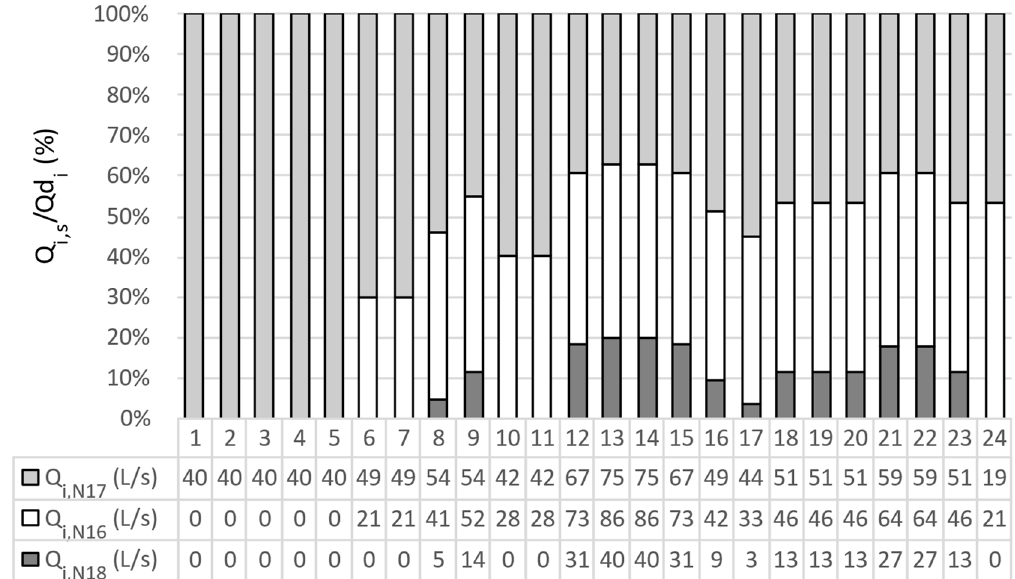
Figure 8. Flow distribution in the case of cost optimization.